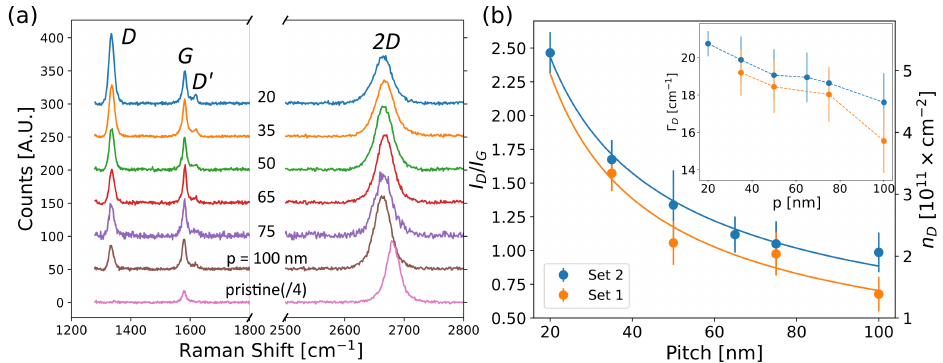
Figure 4. ( a ) Averaged Raman spectra taken on graphene patterned with different pitches p . Each spectrum is shifted 50 A.U. and the spectrum collected on the pristine graphene is divided by 4. ( b ) Plot of the ratio I D / I G of the intensities of the D and G peaks as a function of the pitch p of the pattern. Full lines are the the fitting curves based on Equation (2). Inset, the width Γ D of the D peak is plotted as a function of the pitch p . Standard deviations are used as error bars.